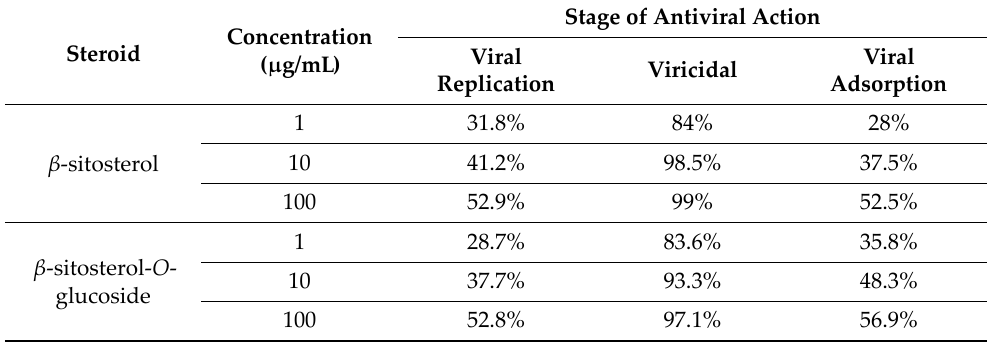
Table 3. The mechanism of action(s) for the highly effective steroids as depicted through plaque reduction % in a concentration‑dependent manner.